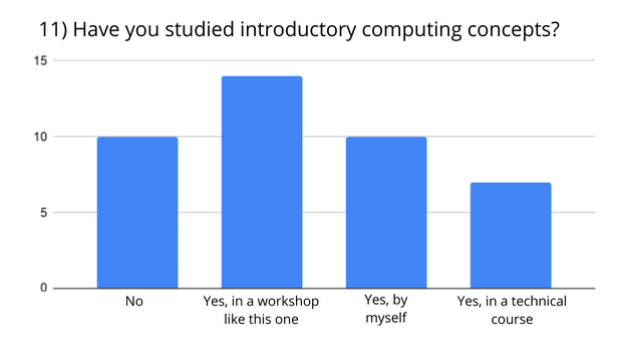
Figure 4 . Graph with the responses to the question “Have you studied introductory computing